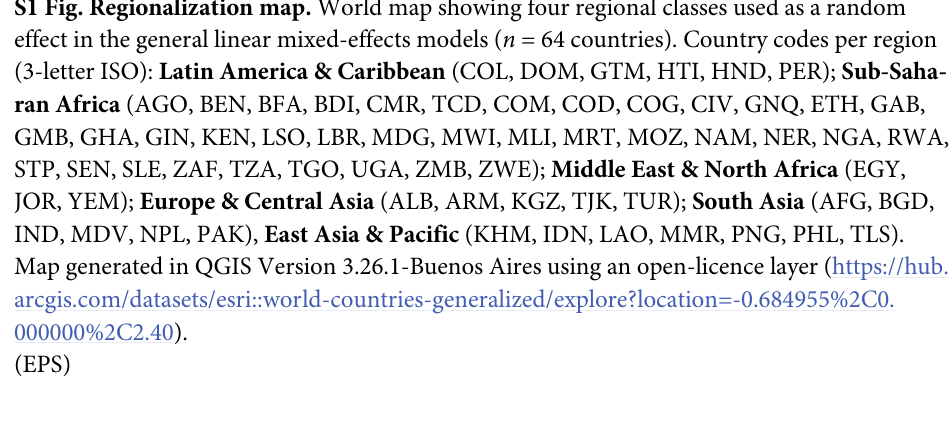
Map generated in QGIS Version 3.26.1-Buenos Aires using an open-licence layer (https://hub. arcgis.com/datasets/esri::world-countries-generalized/explore?location=-0.684955%2C0.